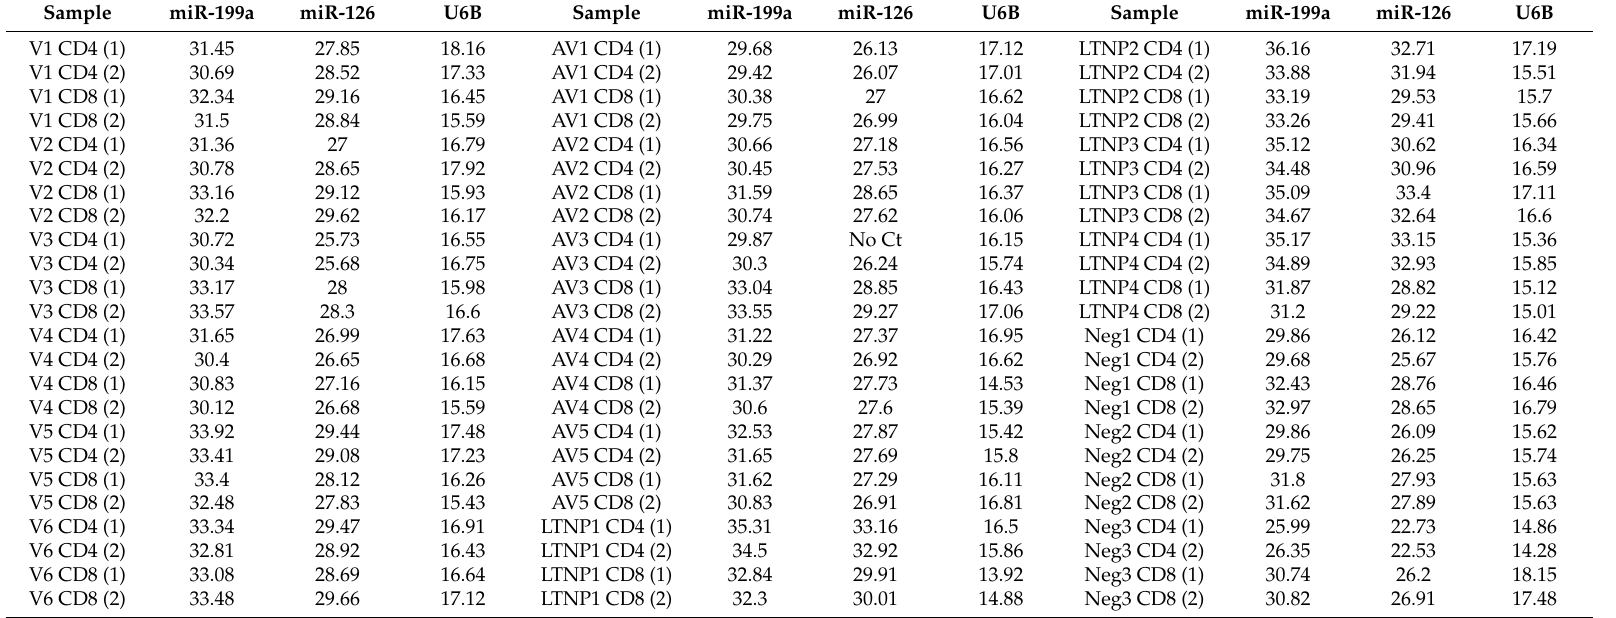
Table A6. qRT-PCR raw amplification